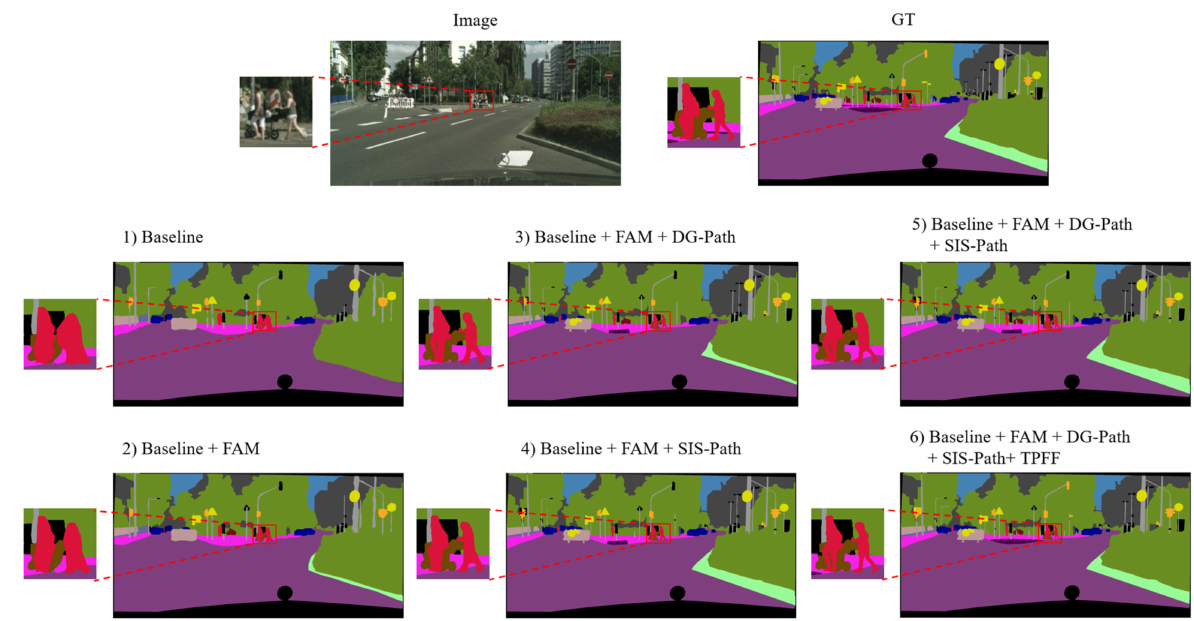
Figure 6. Ablation study results and the ground truth